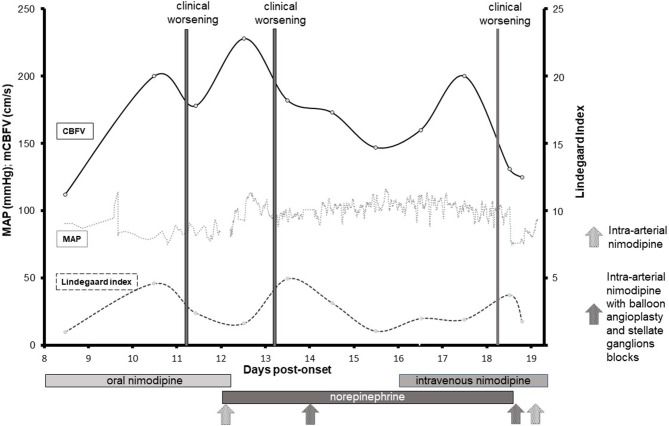
Evolution of physiological measures and effect of treatments. Evolution of mean arterial pressure (MAP), mean cerebral blood flow velocity (mCBFV), and Lindegaard index from Day 8 to 19. The three gray vertical bars indicate the episodes of clinical deterioration (Day 11, 13, 18).